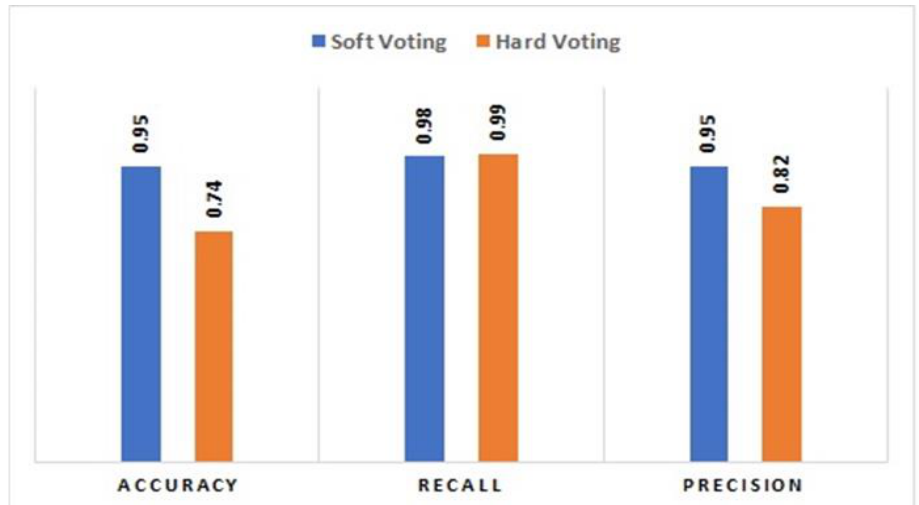
Figure 5. ROC curve Showing performance of ( a ) Majority Voting Hard and ( b ) Majority Voting Soft.